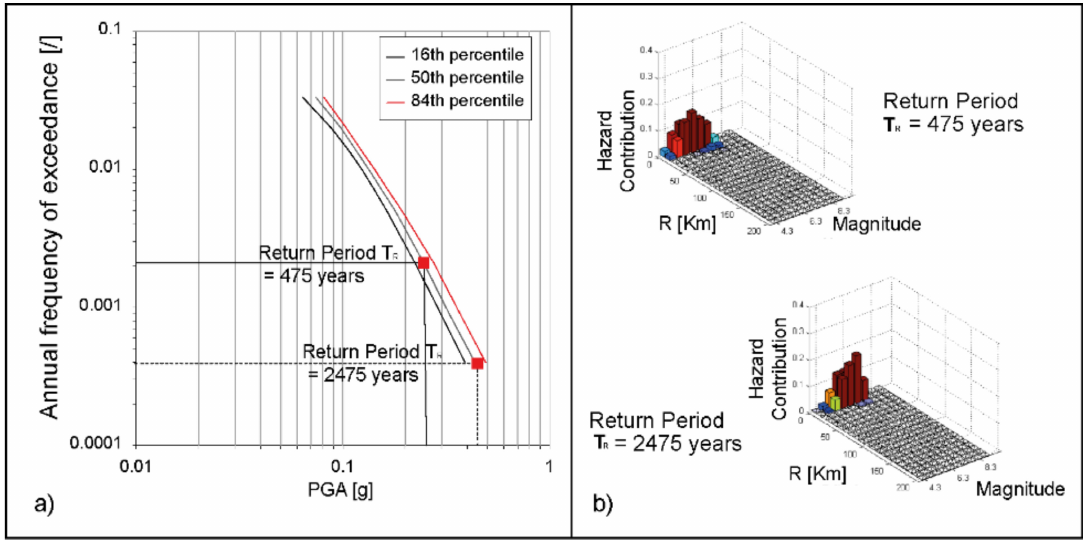
Figure 14. ( a ) PGA as a function of the annual frequencies of exceedance; ( b ) disaggregation analyses for 475. years and 2475 years and for PGA (Ts =